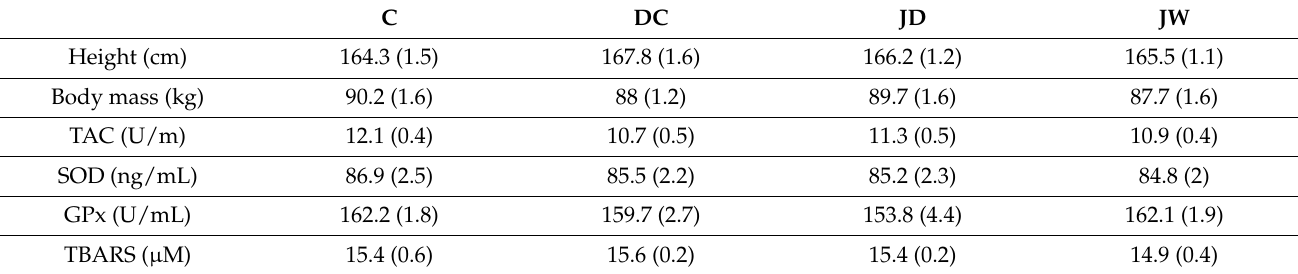
Table 3. Descriptive characteristics of participants’ values represent mean standard error in